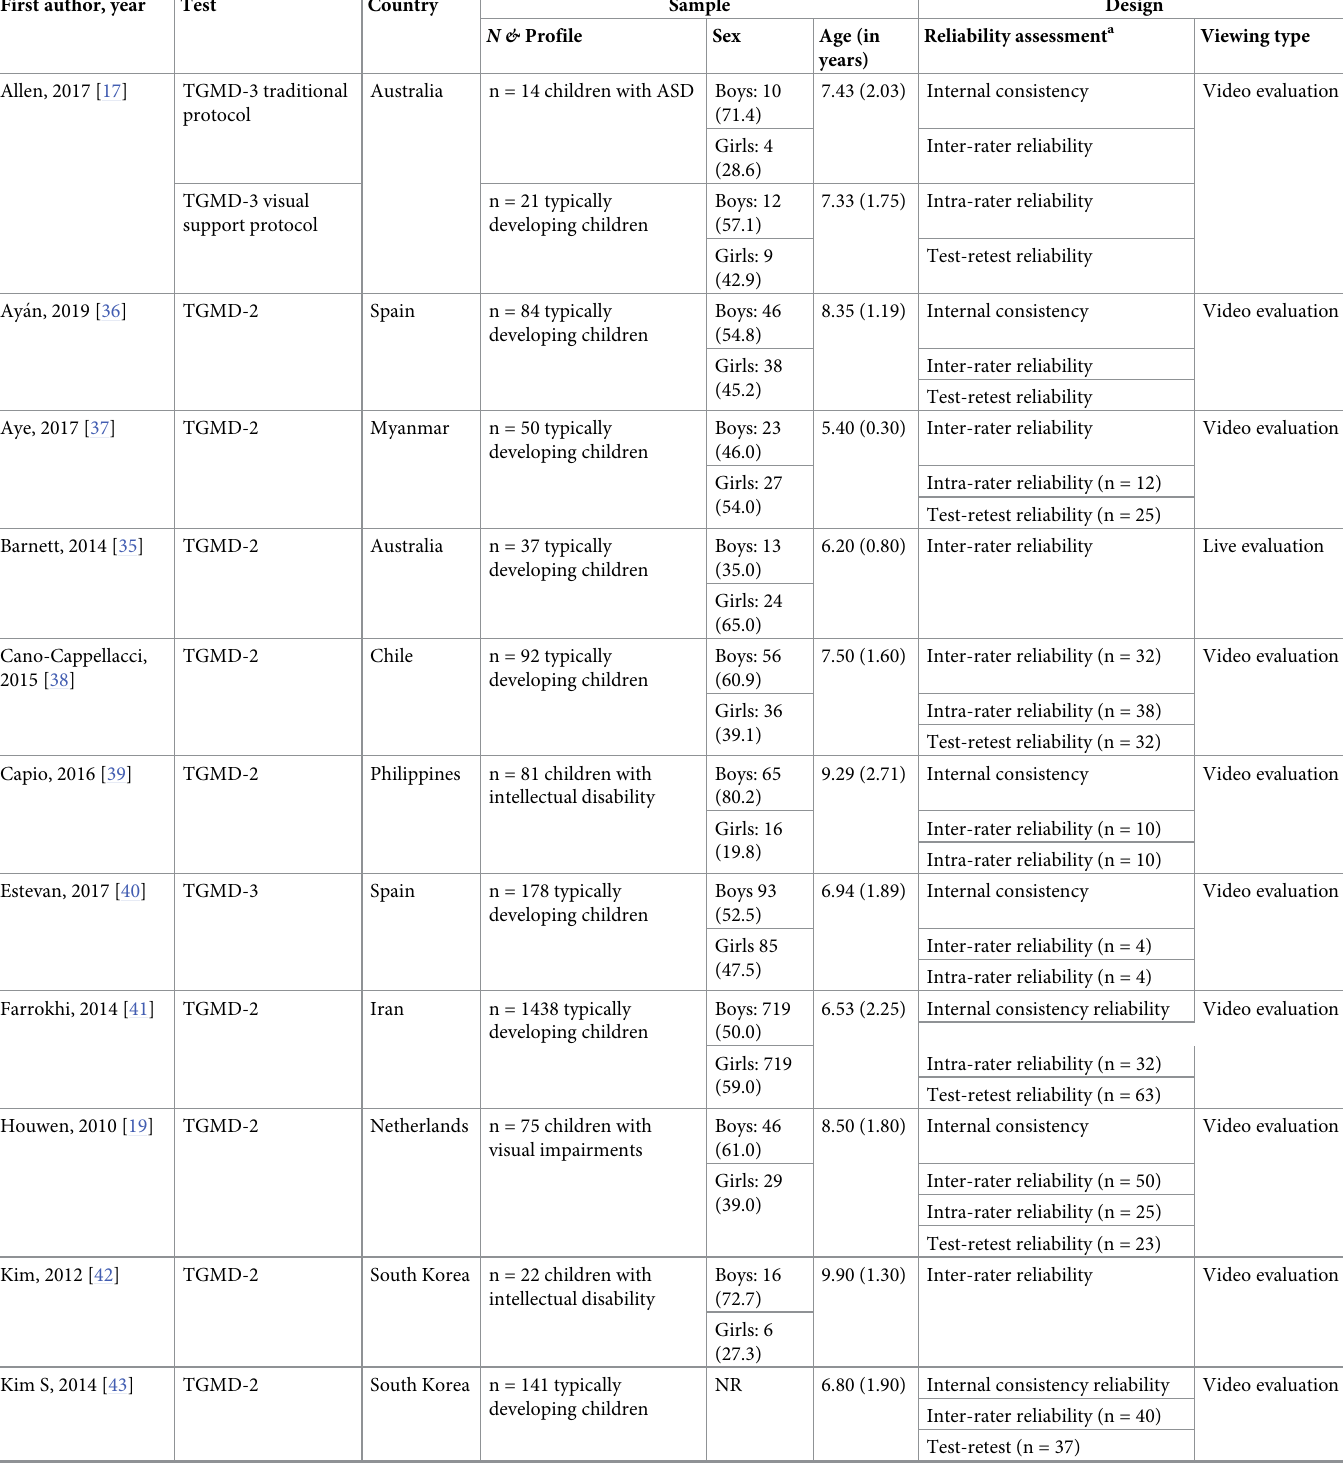
Table 2. Summary of the studies included in the